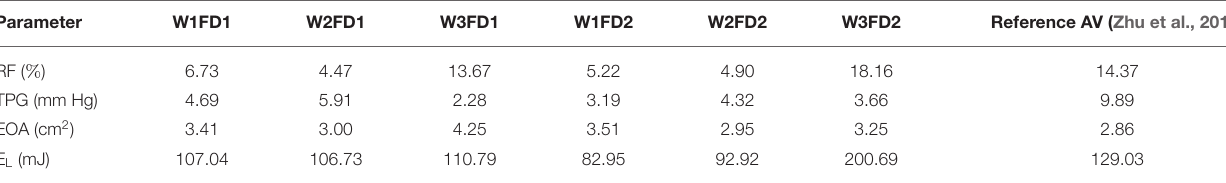
TABLE 7 | The simulated hemodynamic parameters.